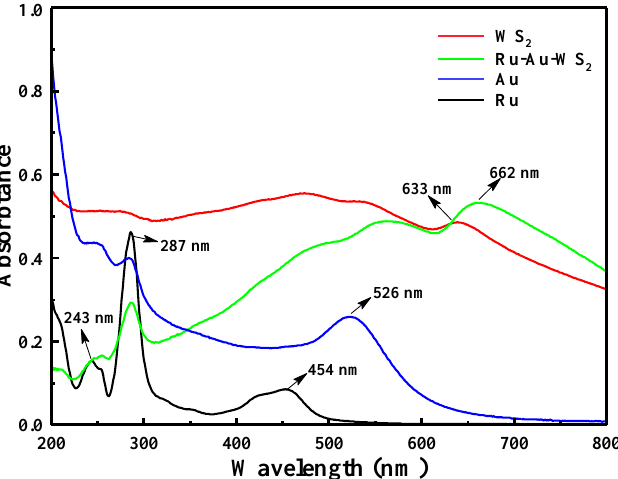
Figure 3. UV-vis absorption spectra of Au, Ru, WS 2 and Ru-Au-WS 2 NCs.